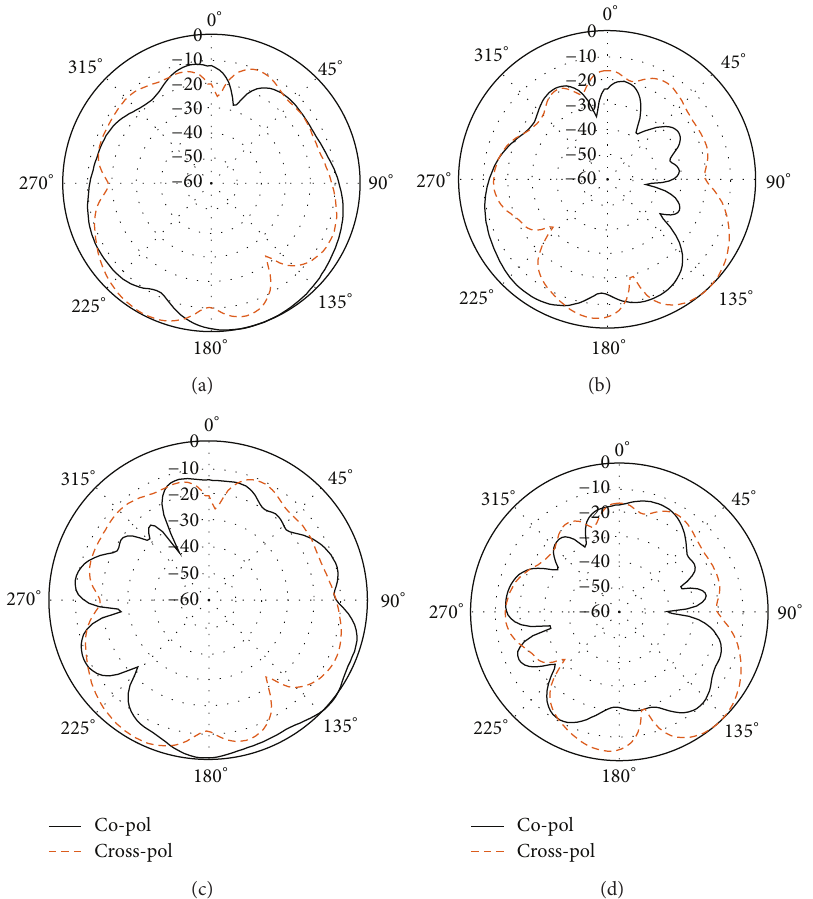
Figure 12: Simulated normalized radiation pattern of the antenna at (a) 5.7 GHz E-plane, (b) 5.7 GHz H-plane, (c) 7.6GHz E-plane, and (d) 7.6 GHz